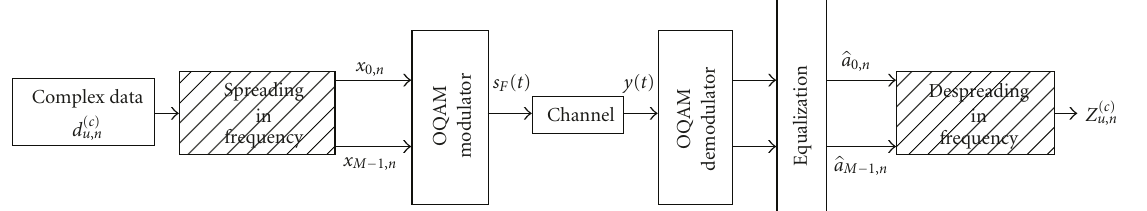
Figure 4: Transmission scheme for the CDMA-OFDM/OQAM system with spreading in frequency of complex